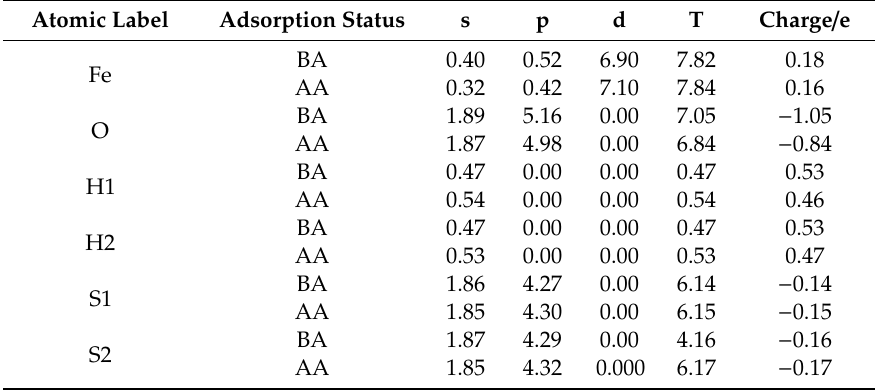
Table 4. Mulliken charge population (MCP) of atoms on the ideal pyrite surface.